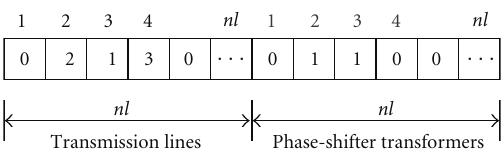
Figure 5: Encoding proposal (chromosome).